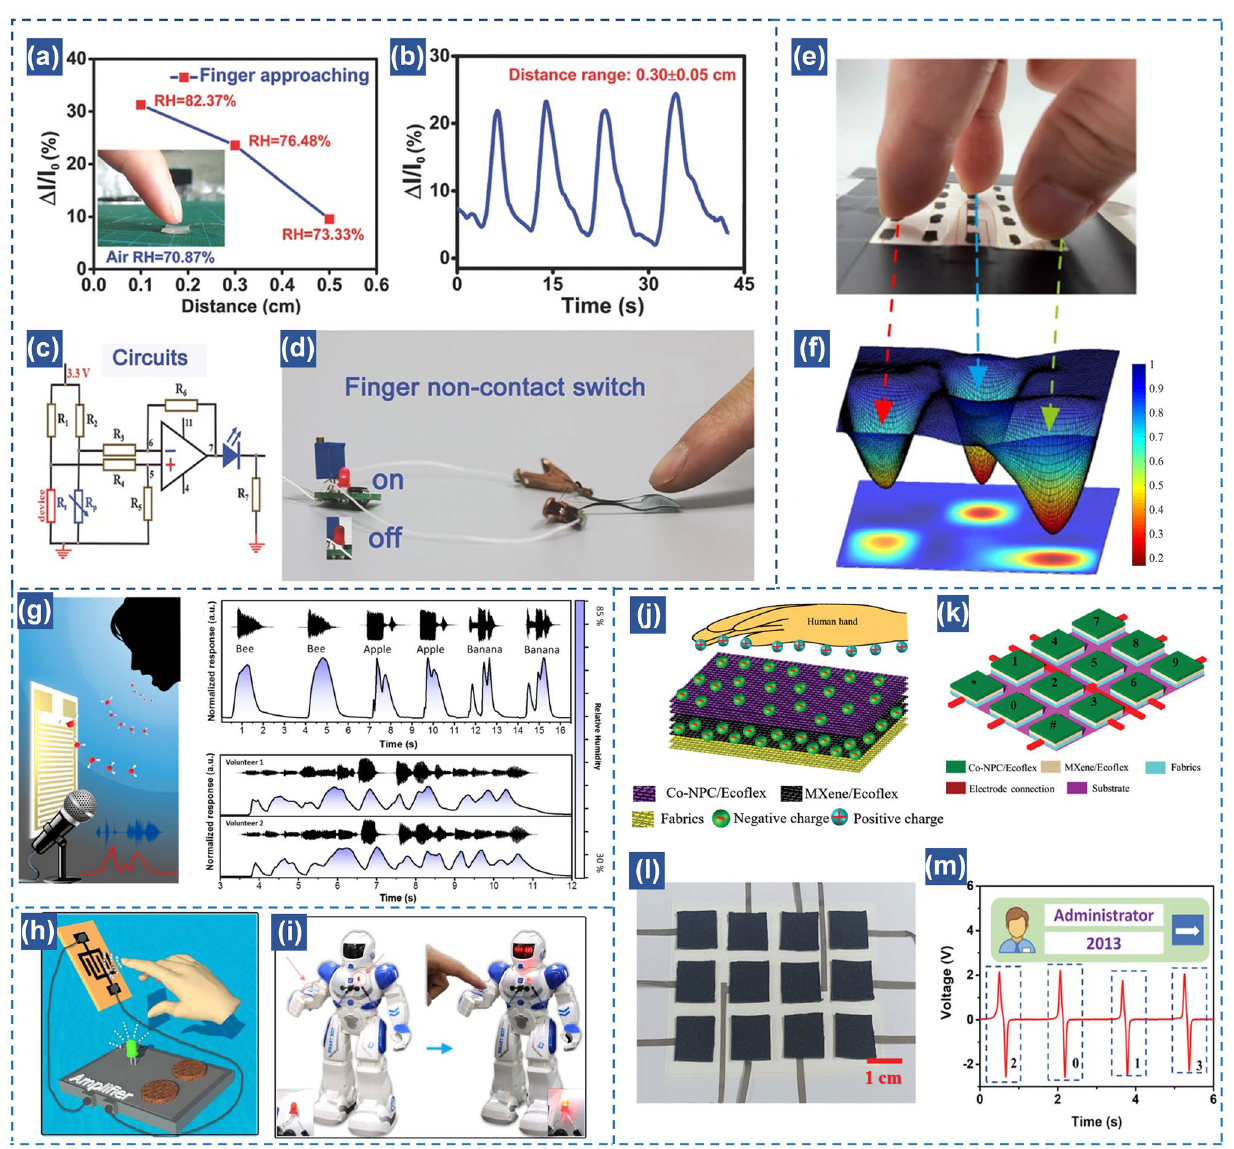
Fig. 10 Noncontact human–machine interfaces. ( a ) Measurements of the porous ionic membrane (PIM)-based sensor at different distances between the finger and the PIM (air RH of 70.87%); the inset shows the scene of a finger approaching the PIM. ( b ) The repeatability of the noncontact PIM-based sensor for 0.3 ± 0.05 cm with four circles under air RH of 76.48%. ( c ) The configuration of the noncontact switch circuit system; the sensor resistance was R t and the reference resistance was R p . ( d ) The photograph of a finger noncontact humidity switch system, and it will display the finger approaching by the on–off and degrees of brightness of a LED light [168]. Copyright 2017 Wiley. ( e–f ) 3D mapping of the approaching of three fingertips [75]. Copyright 2019 ACS Publications. ( g ) Schematic illustration of a humidity sensor for human exhaled air detection during speaking [53]. Copyright 2018 ACS Publications. ( h ) Schematic illustration of a visible finger position annunciator. ( i ) IPMEC attached on a robot as artificial skin for the detection of an approaching finger [169]. Copyright 2018 Elsevier. ( j ) Schematic illustration of the Co-NPC/Ecoflex nanocomposite based double-layer non-contact mode TENG. ( k ) Schematic illustration of a smart door lock password authenti- cation system. ( l ) Fabricated prototype of the smart door password authentication system. ( m ) Schematic diagram of the password authentication and output voltage waveform for the CDL-TENG. [35]. Copyright 2021